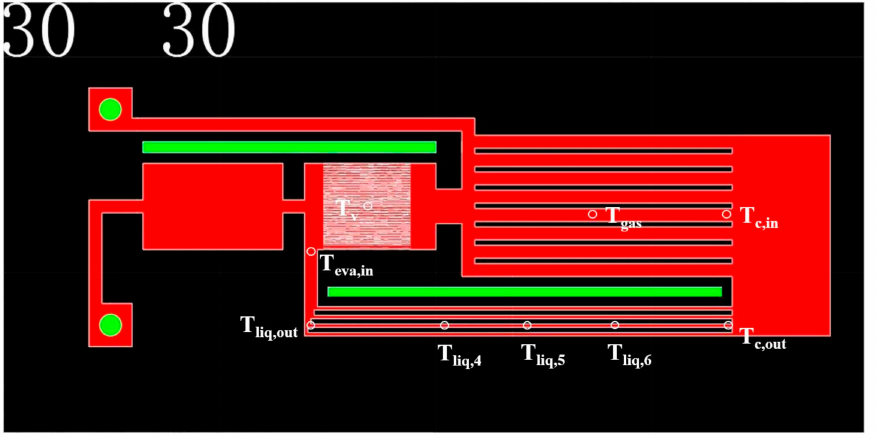
Figure 4. The layout of the thermocouple for temperature measurement. T eva, in —evaporation